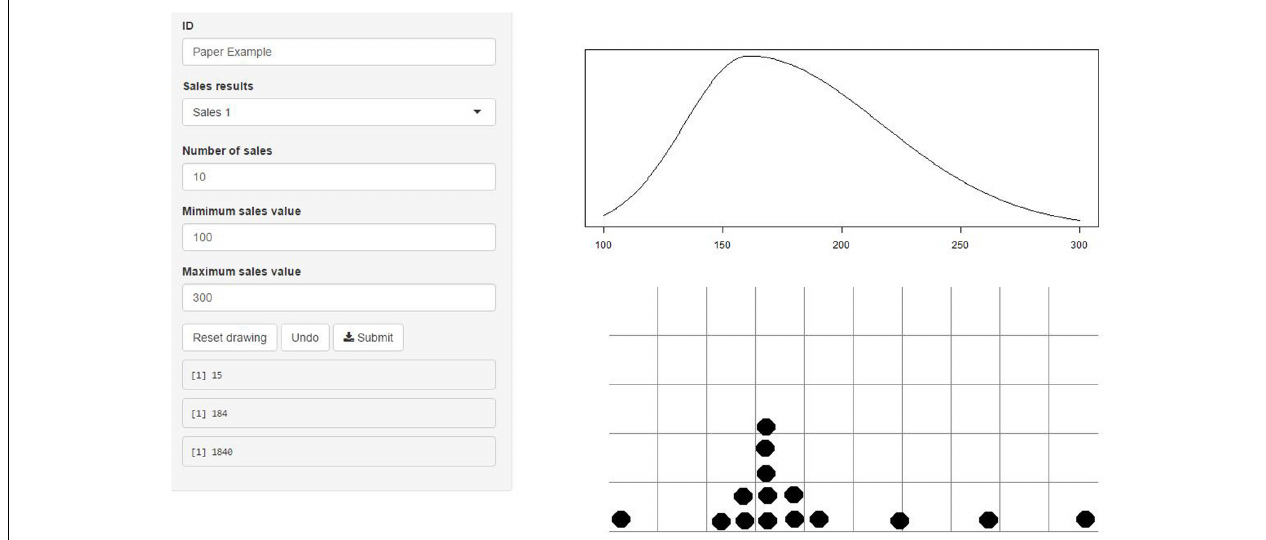
FIGURE 1 | Shiny application for steps 1 and 2. On the left the input fields can be found for the reasonable lower and upper bound as minimum and maximum values. The input grid in which “chips” can be placed is found on the lower right with the leftmost dot being the minimum value and the right most dot being the maximum value. Further “chips” are placed by clicking the mouse drawing a maximum of 11 pixels left and right. On the top right feedback is provided, presenting the fitted distribution based on the input.